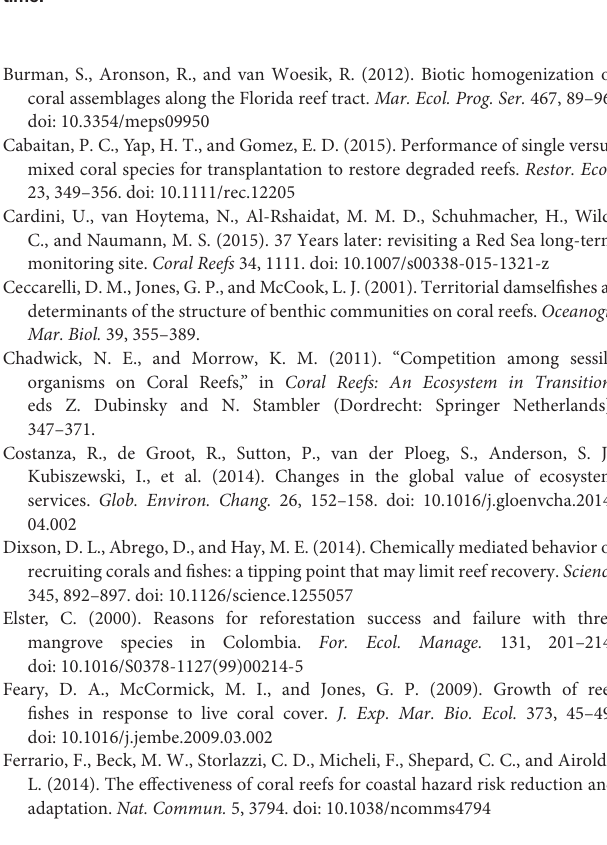
Supplementary Table 2 | Results from nested two-way repeated measures ANOVA for treatment effects on individual colony growth rate, TLE, live TLE, and results from two-way ANOVA for plot level TLE, live TLE, and survivorship. Supplementary Figure 1 | Survivorship of coral colonies by genotype over